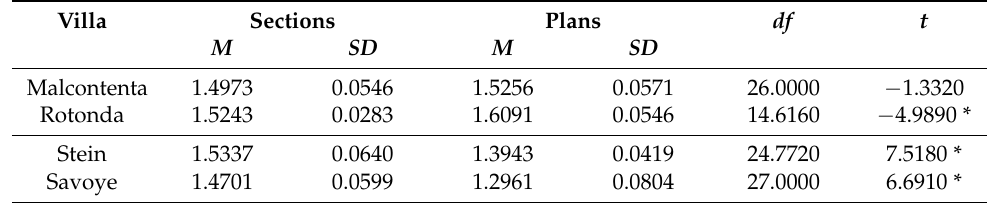
Table 4. t -test results for H1.1 and H1.2. Villa